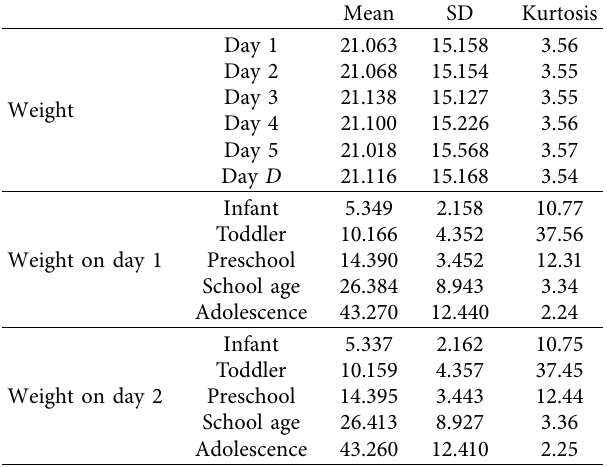
Figure 2: Histogram for weight difference (WeightDiff) between day t , for t � 2 , 3 , 4, and the day of discharge ( D ), against day 1 with the normal curve. (a) WeightDiff 21, (b) WeightDiff 31, (c) WeightDiff 41, and (d) WeightDiff D1. Table 1: Summary of statistics for patients’ (i) weight (from day 1 to day 5 and the day of discharge) and (ii) weight on day 1 and day 2 for each level of